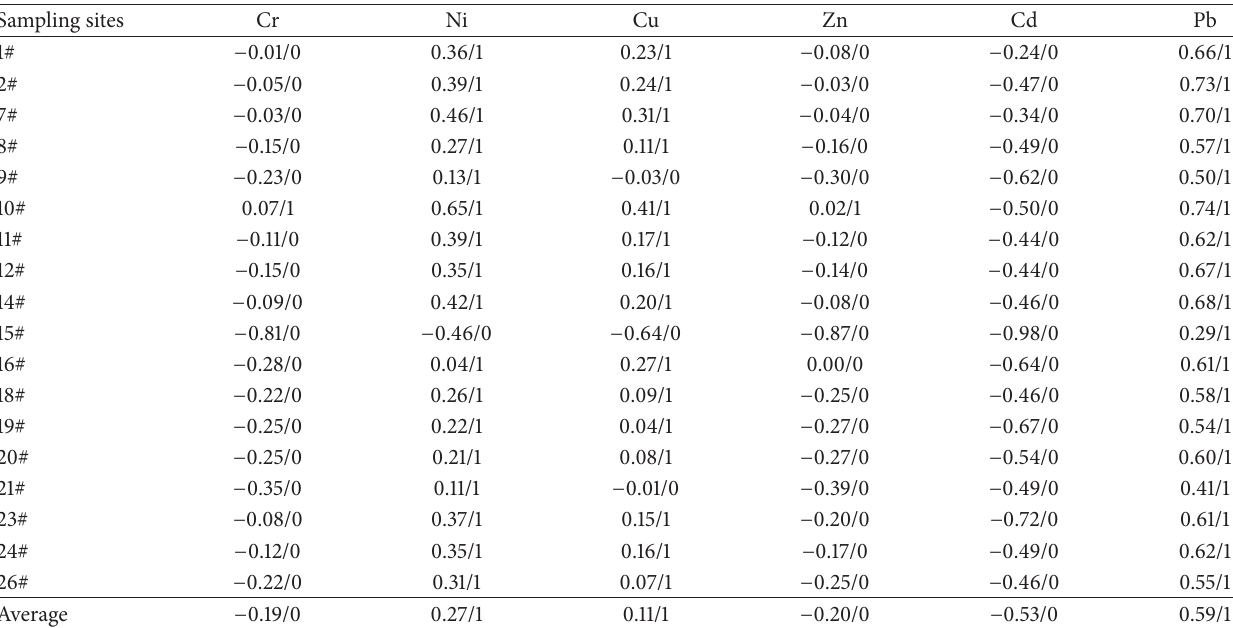
Table 2: 𝐼 values of heavy metals in surface sediments of Bohai geo